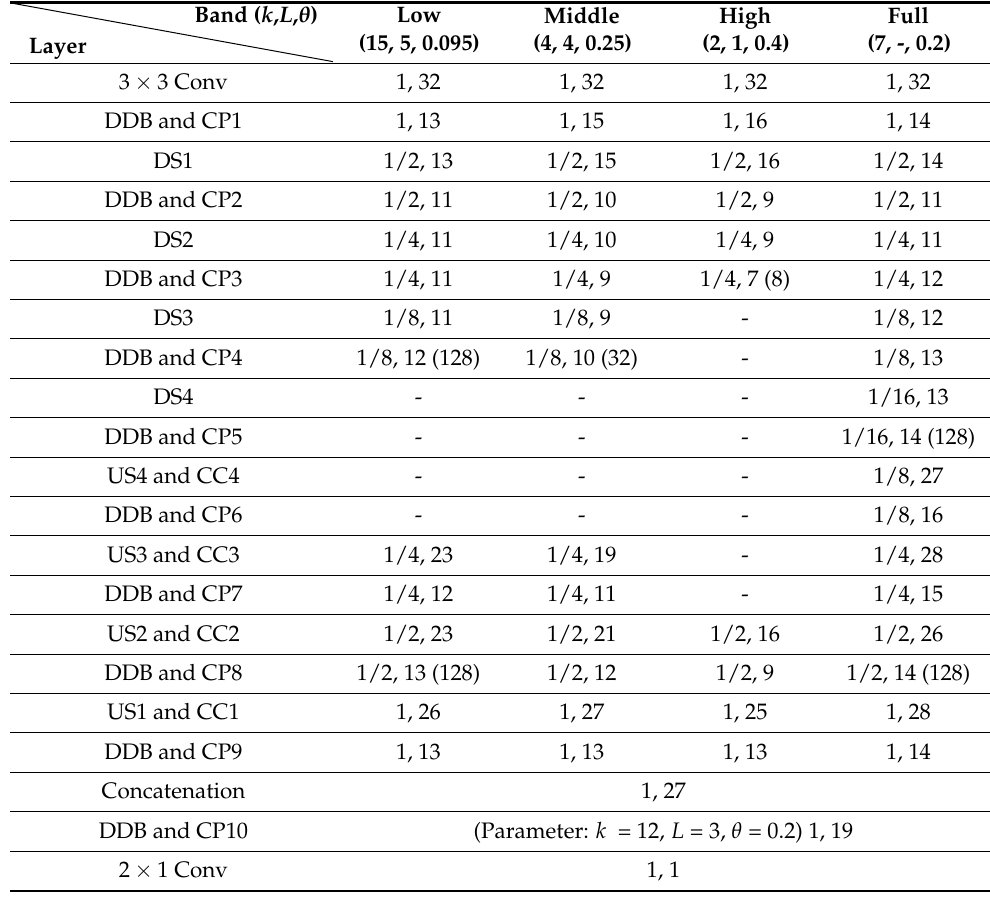
Table 1. Details of the proposed architecture (scale, the number of output feature map). If the bidirectional long short-term memory (BLSTM) layer was applied, the number of nodes was indicated in parentheses. The “ L ” of full band is shown in Figure 2. The lack of values indicates no architecture. Therefore, DDB and CP4 of the low band is connected to US3 and CC3. k : growth rate, L : the number of the composite function, θ : compression rate, DDB: dilated dense block, CP: compression block, DS: down-sampling, US: up-sampling, CC: